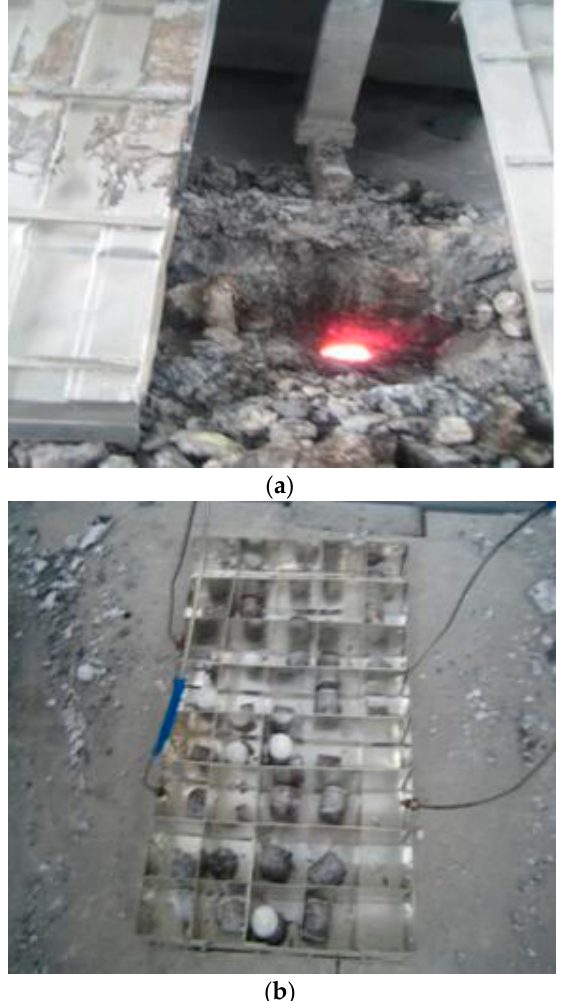
Figure 3. Field of collecting alumina concentration data. ( a ) The location of the electrolyte sampling; ( b ) The collected electrolyte samples.